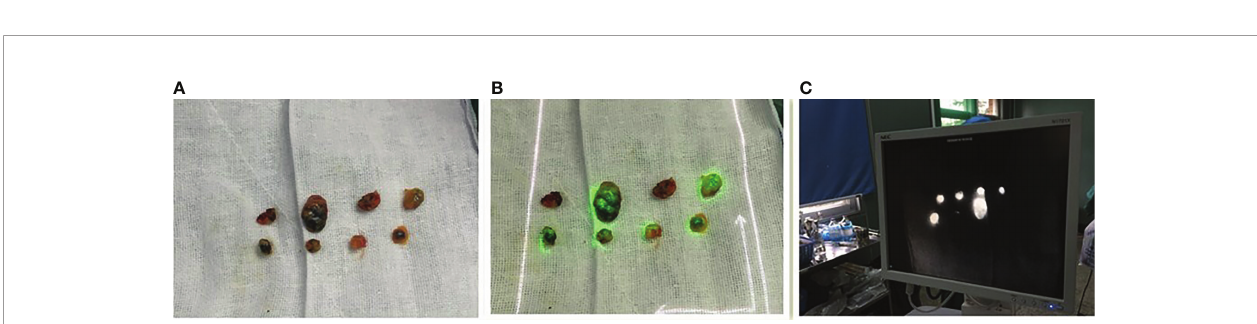
FIGURE 4 | Image of resected lymph nodes. (A) Left one: The MB lymph node. (B) Middle one: The ICG lymph nodes with the LFIS. (C) Right one: The ICG lymph nodes with the Langfang Vascular